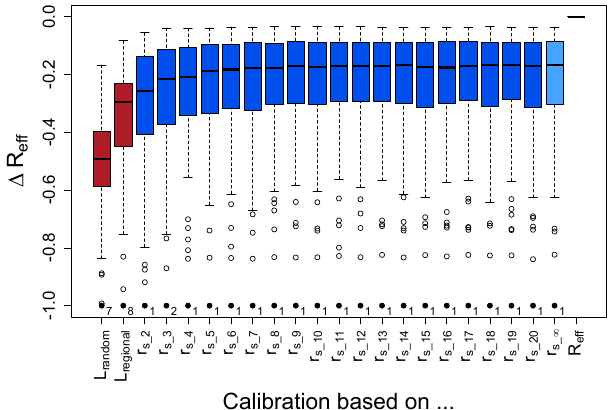
Calibration based on ... Figure 2. Box plots of the difference in the median model efficiency and the upper benchmark ( (cid:49)R eff ) for all 100 catchments for the models calibrated on stream level class data (2 to 20 classes; r s_ n ), 0 models calibrated on high-resolution stream level data ( r s_ ∞ ), and the two lower benchmarks ( L random and L regional ). The box rep- resents the interquartile range, the solid line represents the median, Figure 3. Difference in the median model validation result (model the whiskers reach to the furthest catchment that is still within a dis- efficiency) for the models calibrated using two water level classes tance of 1.5 times the interquartile range from the box, and the dots ( r s_2 ) and five water level classes ( r s_5 ) for all 100 catchments as represent the outliers. a function of the aridity index ( P/E pot ). The colour of the sym- bols represents the difference between the upper and lower bench- marks (i.e. the difference in the median model performance when the model is calibrated with all available streamflow data ( R eff ) and when the model is run with randomly selected parameters (i.e. without any calibration; L random ) ). Triangles indicate outliers that would plot outside the range of the y